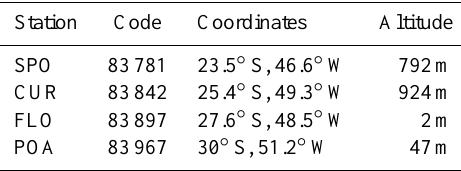
Table 1. Information on the weather stations in this